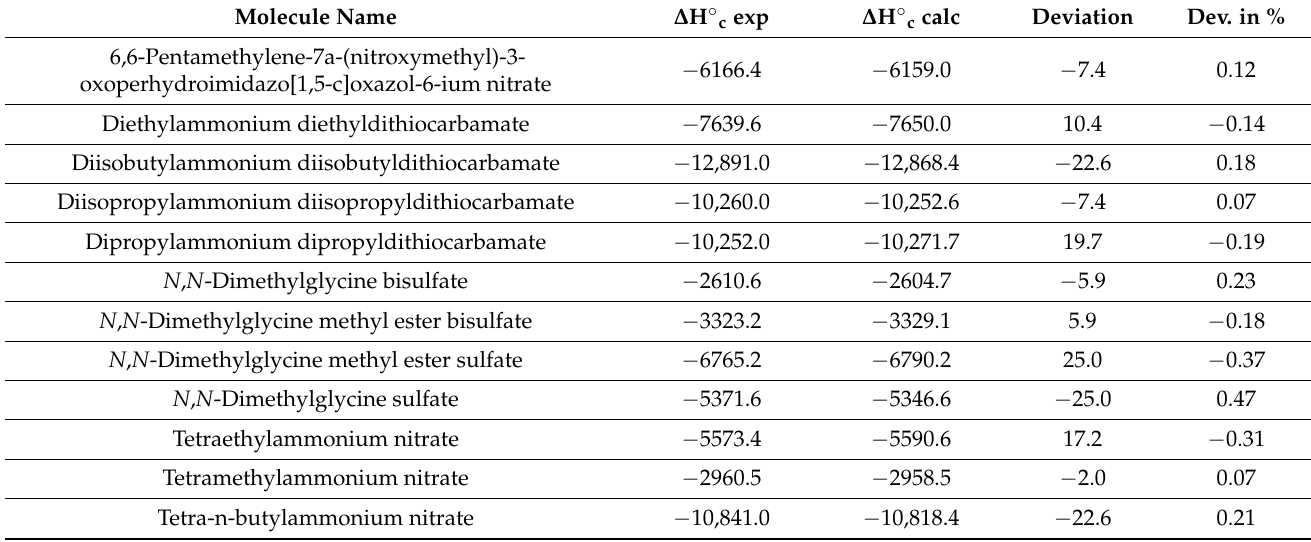
2 = 0.9979, regression